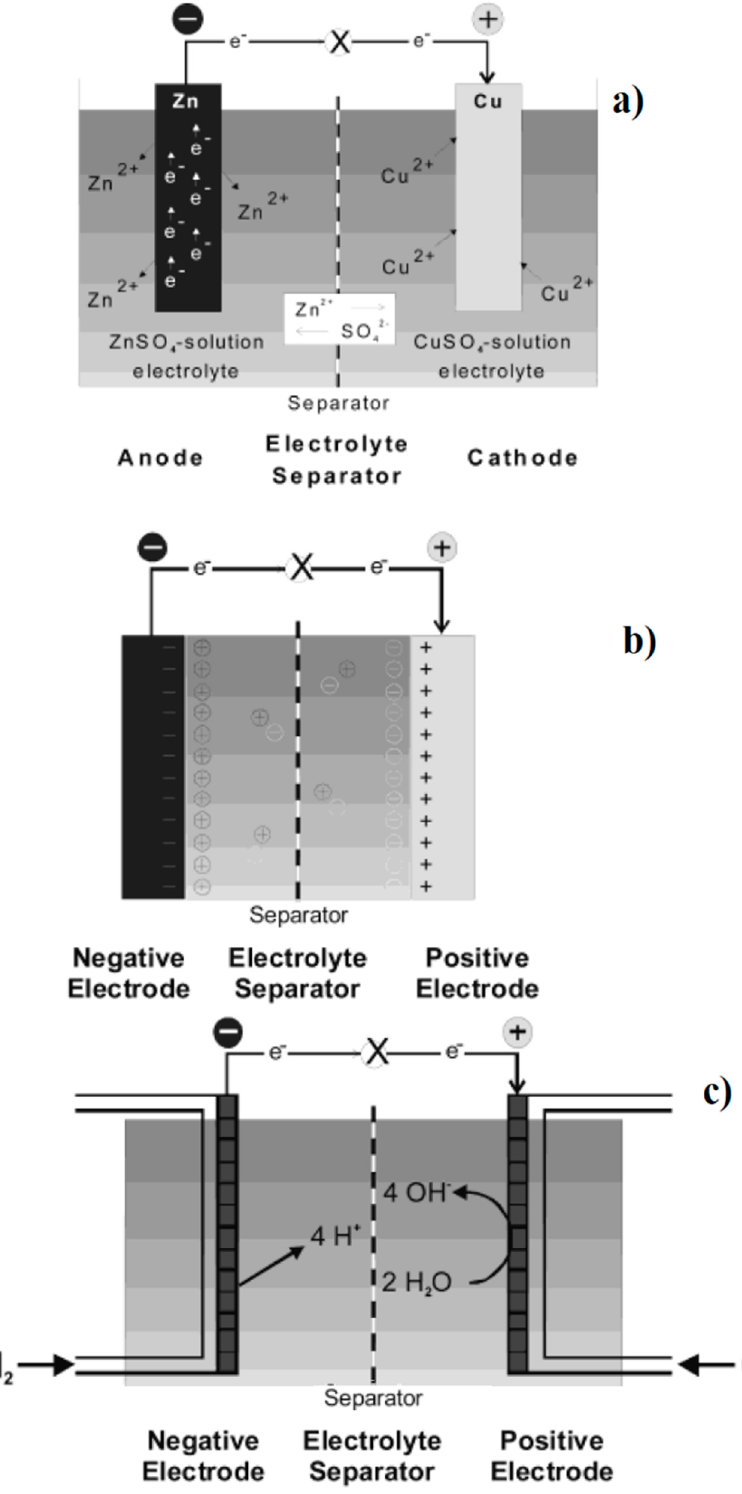
Figure 5. Schematic representation of ( a ) battery (Daniell cell), ( b ) a supercapacitor, and ( c ) a hydrogen fuel cell as reported by Winter et al. [ 219].